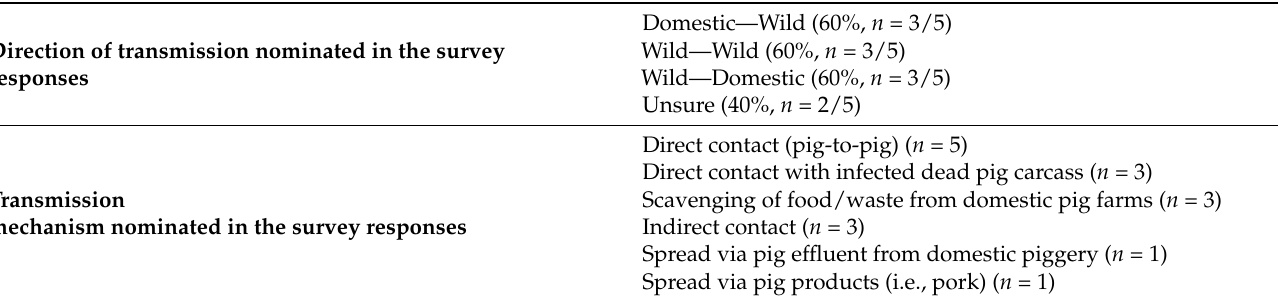
Table 5. African swine fever virus transmission routes in wild suids reported by 5 Members within regions of Asia and the